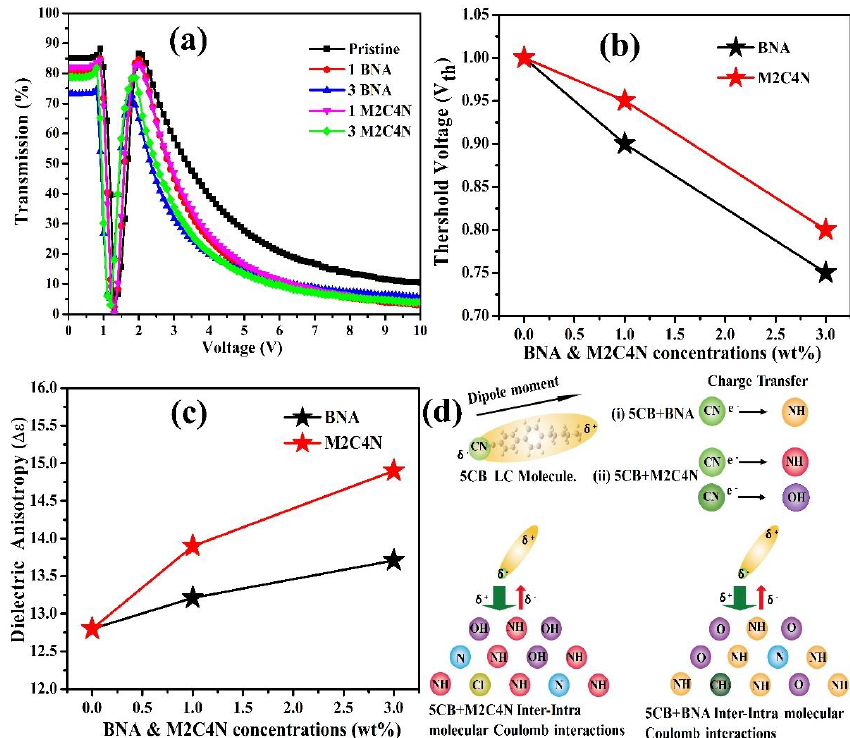
Figure 4. ( a ) V–T curves, ( b ) V th , ( c ) Δε as functions of BNA and M2C4N-doped LC cells at 1 kHz, respectively. ( d ) Schematic illustration of charge transfer (CT) effects in the 5CB-M2C4N (Left side) respectively. ( d ) Schematic illustration of charge transfer (CT) e ff ects in the 5CB-M2C4N (Left side) and 5CB-BNA (Right side), respectively. and 5CB-BNA (Right side),